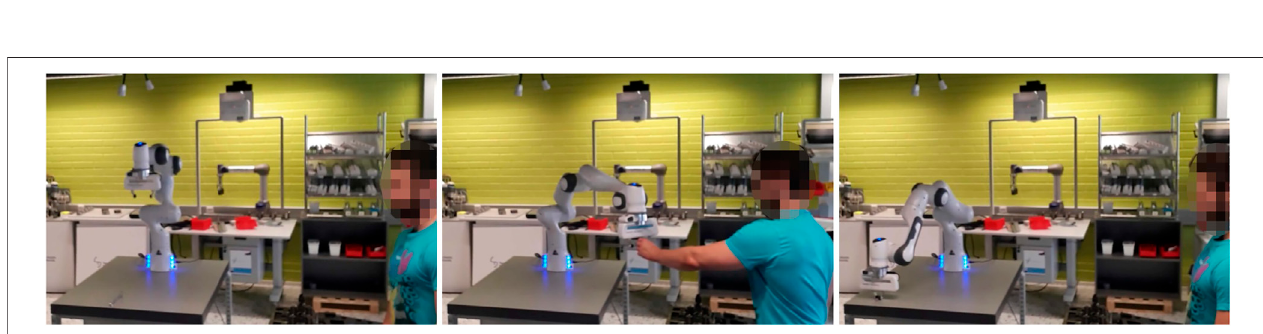
Frontiers in Robotics and AI |